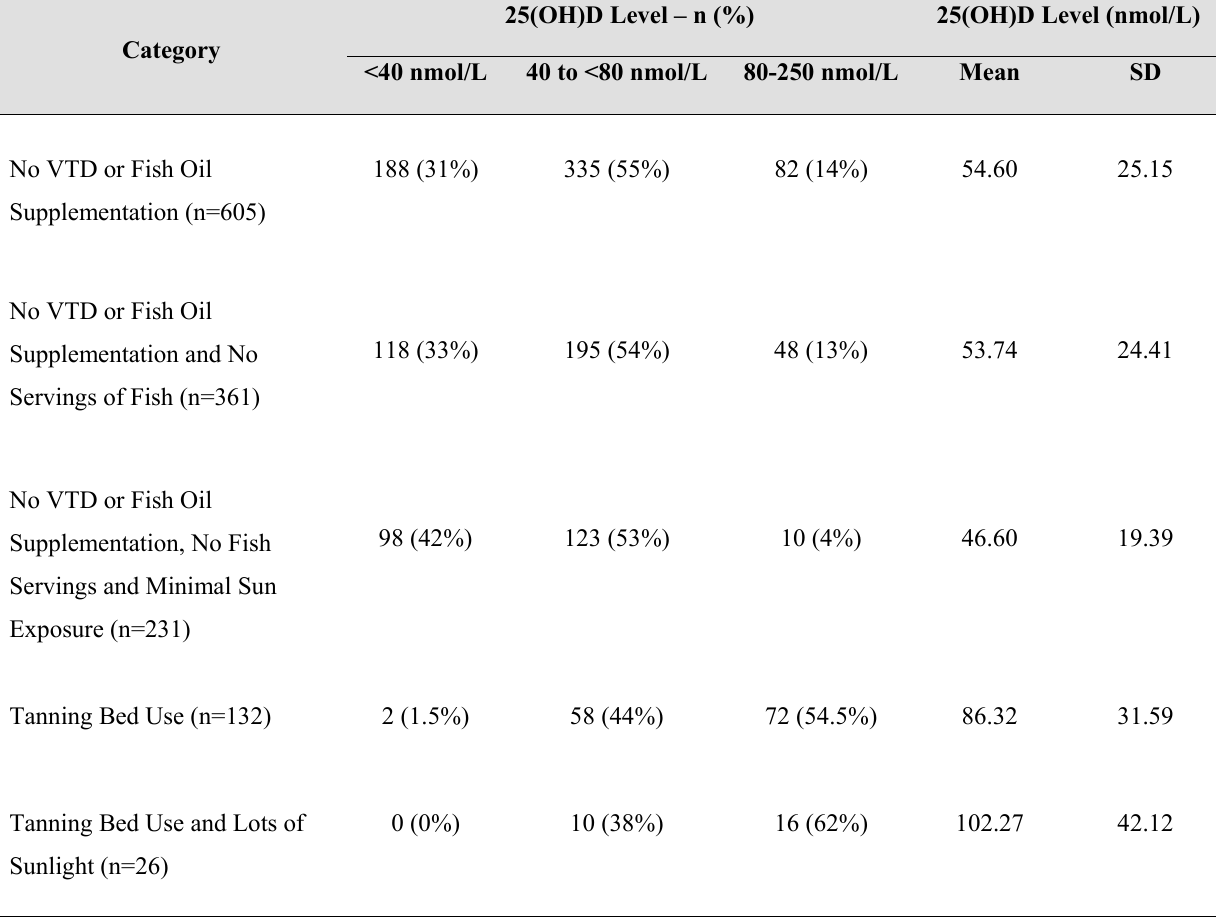
Table 5. Vitamin D Status by Significant Lifestyle